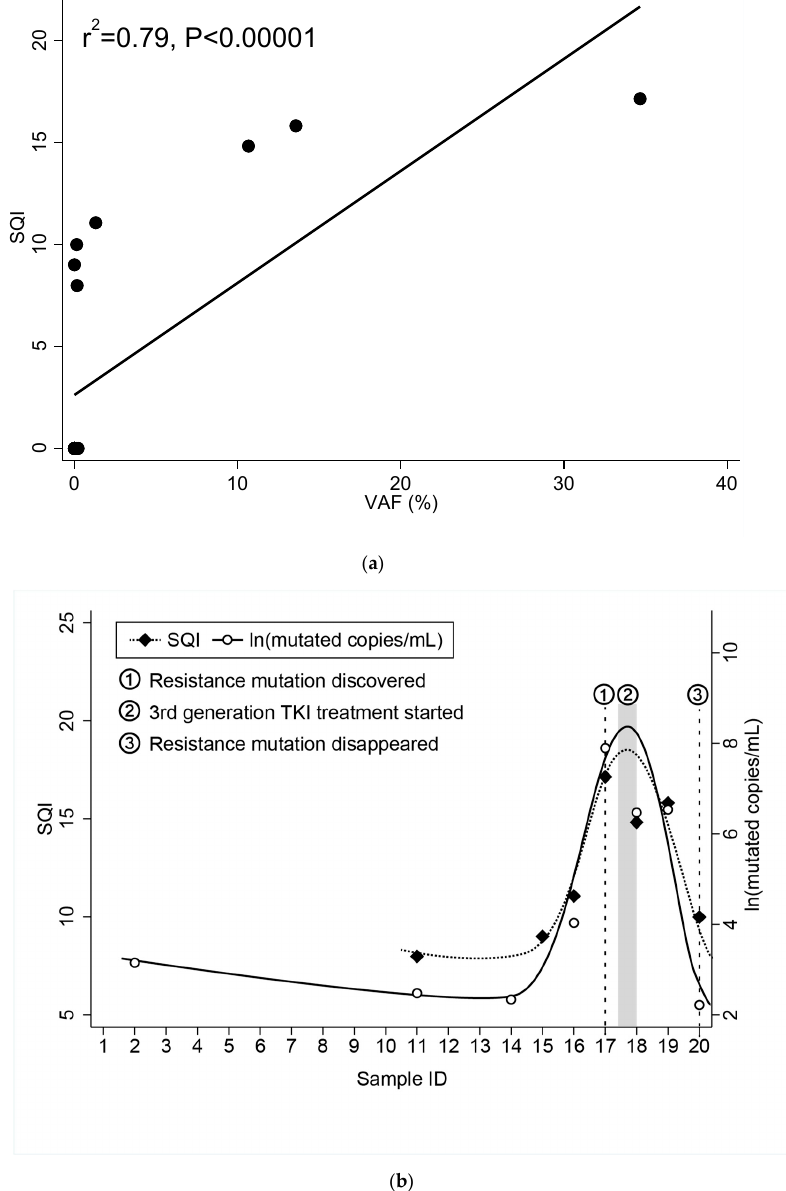
Figure 2. ( a ) Correlation between SQI and VAF in patient ID15. ( b ) Chronological monitoring of SQI and ln(mutated copies/mL) in patient ID 15. Samples in chronological order with one month between each sample. Guides to the eye are included to indicate the trend in the values as resistance mutation was found and treatment adjusted.